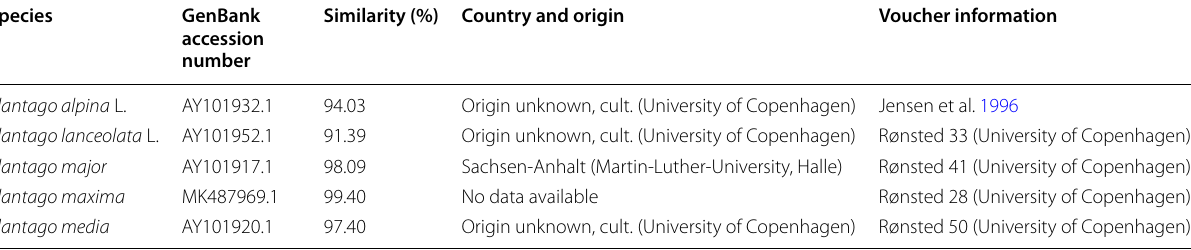
Table 4 Sequence information for Plantago species retrieved from GenBank